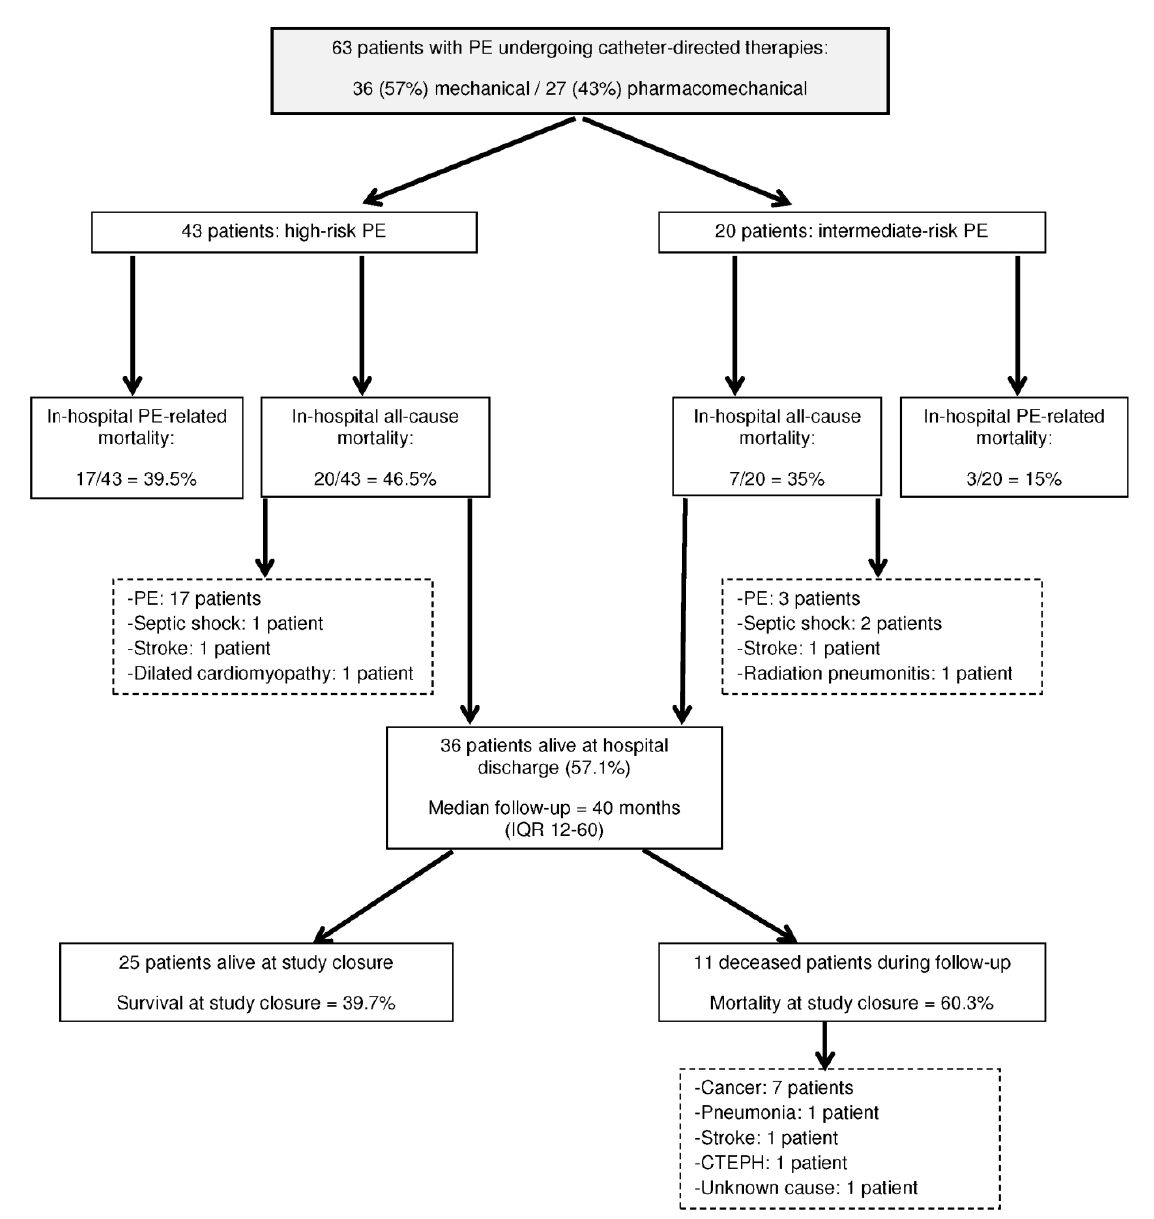
Figure 1. Diagram showing mortality distribution throughout the study. Abbreviations: PE, pulmonary embolism; IQR, interquartile range; CTEPH, chronic thromboembolic pulmonary hypertension.